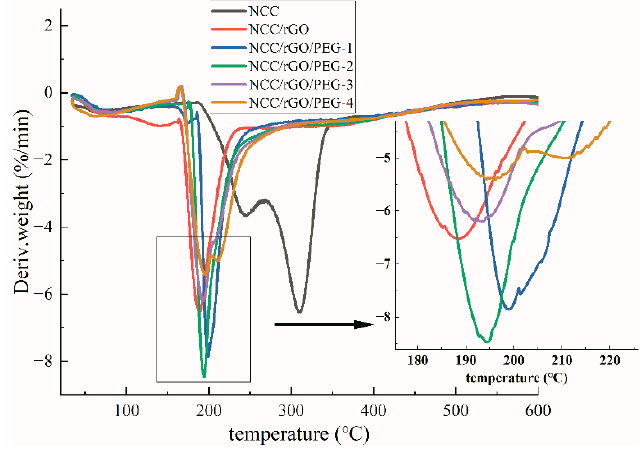
Figure 6. Derivative thermogravimetric (DTG) of NCC film and its composite film.